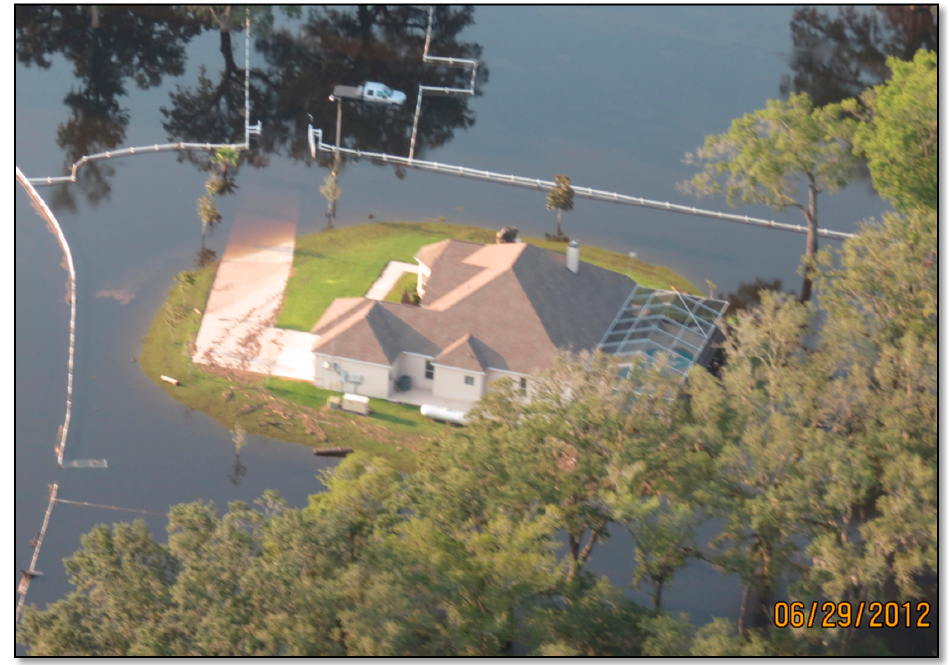
Figure 5. Oblique image of house taken during Tropical Storm Debby flooding event (June 2012; care of Hernando County Emergency Management).